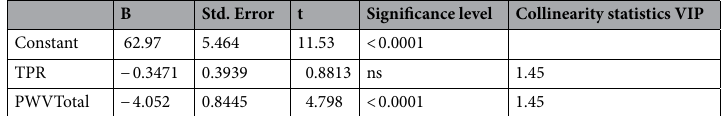
Table 5. Least square multiple regression analysis for left atrial passive emptying volume (LA PEV ) as determined from CMR time-volume curves in 36 healthy young and 16 healthy middle-aged subjects (unstandardized coefficients).